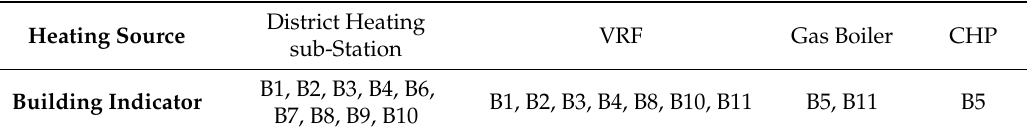
Table 7. Heating sources used in